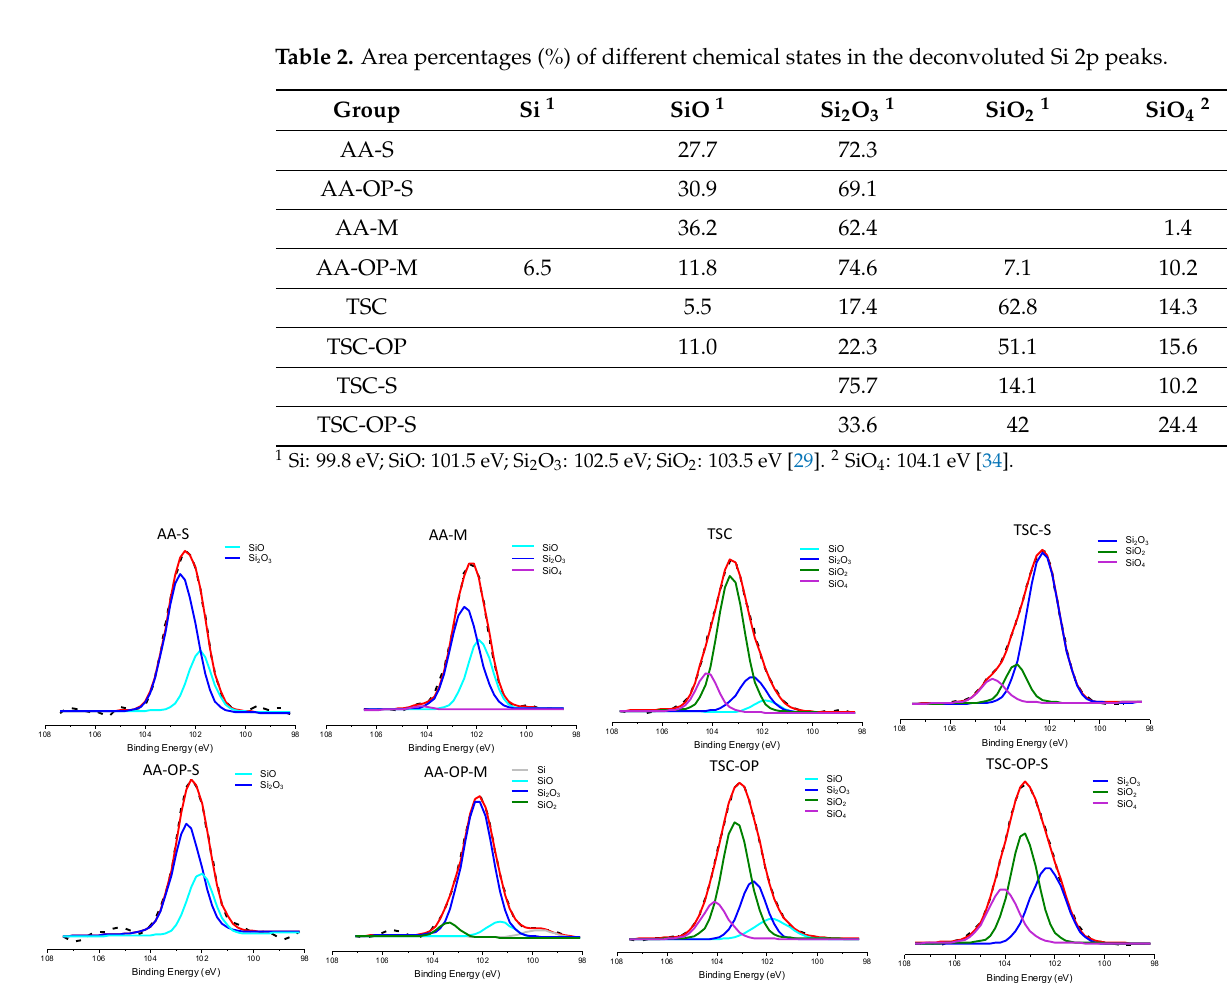
Table 1. XPS analysis revealing the element compositions (%) on the surfaces of the experimental groups.